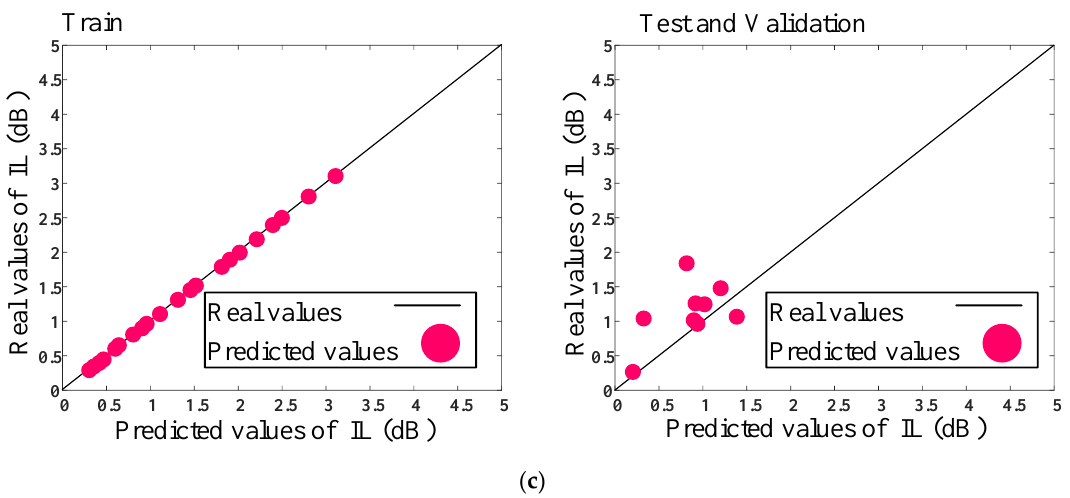
seen, the circuit parameters are predicted accurately. Two samples are chosen for valida- tion, which are shown in Figure 7. The validation samples validate the accuracy of the proposed model and help to design the proposed interdigital filter with the desired pa- rameters. Figure 6. The real and predicted comparison values for train and test data, using the proposed model. Real and predicted values of ( a ) f 0 (GHz), ( b ) BW (MHz), and ( c ) IL (dB). Real and predicted test and train values of f 0 (GHz), BW (MHz), and IL (dB) parame- ters versus the number of data samples in the proposed model are shown in Figure 7. As